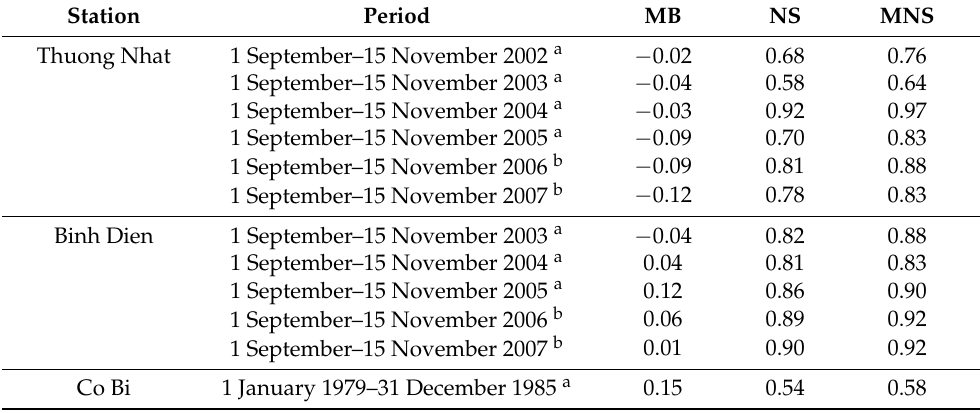
Table 1. Performance criteria of the hydrological WetSpa flood prediction model for the three upstream sub-catchments of the Houng River; MB: model bias (Equation (1)); NS: Nash-Sutcliffe efficiency (Equation (2)); MNS: modified Nash-Sutcliffe efficiency for high flows (Equation (3)). Station Period MB NS MNS Thuong Nhat 1 September–15 November 2002